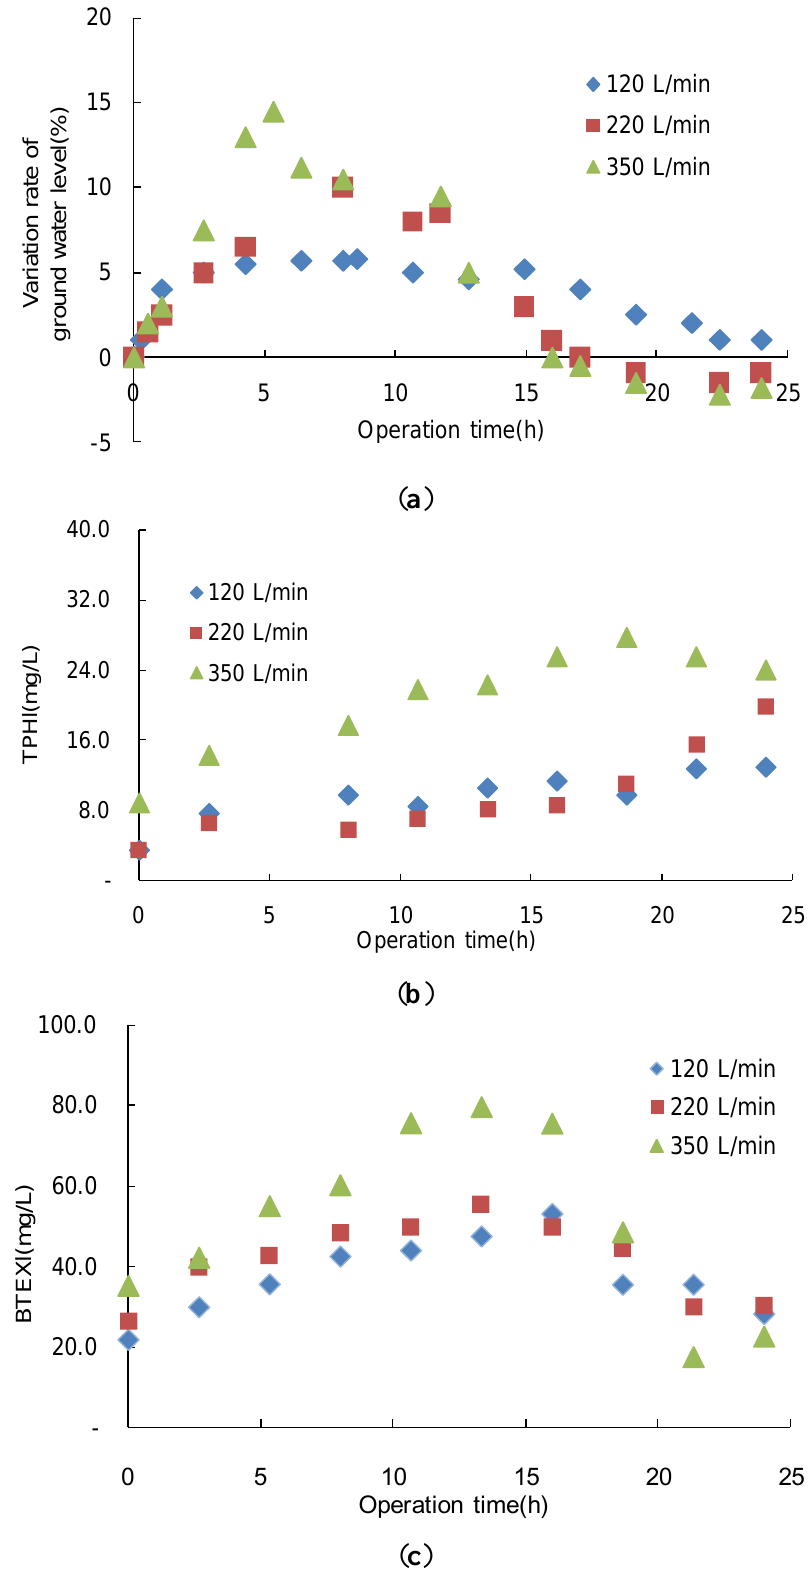
Figure 6 . Variations in ( a ) ground water ( b ) TPH and ( c ) BTEX concentrations with variations in the air injection rate during air